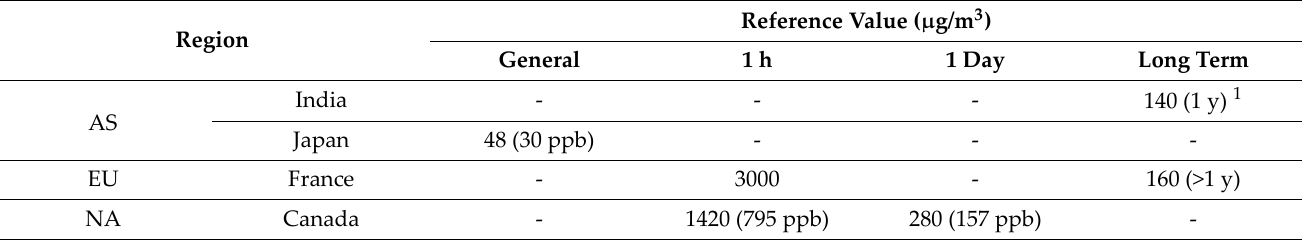
Table 3. Reference values for